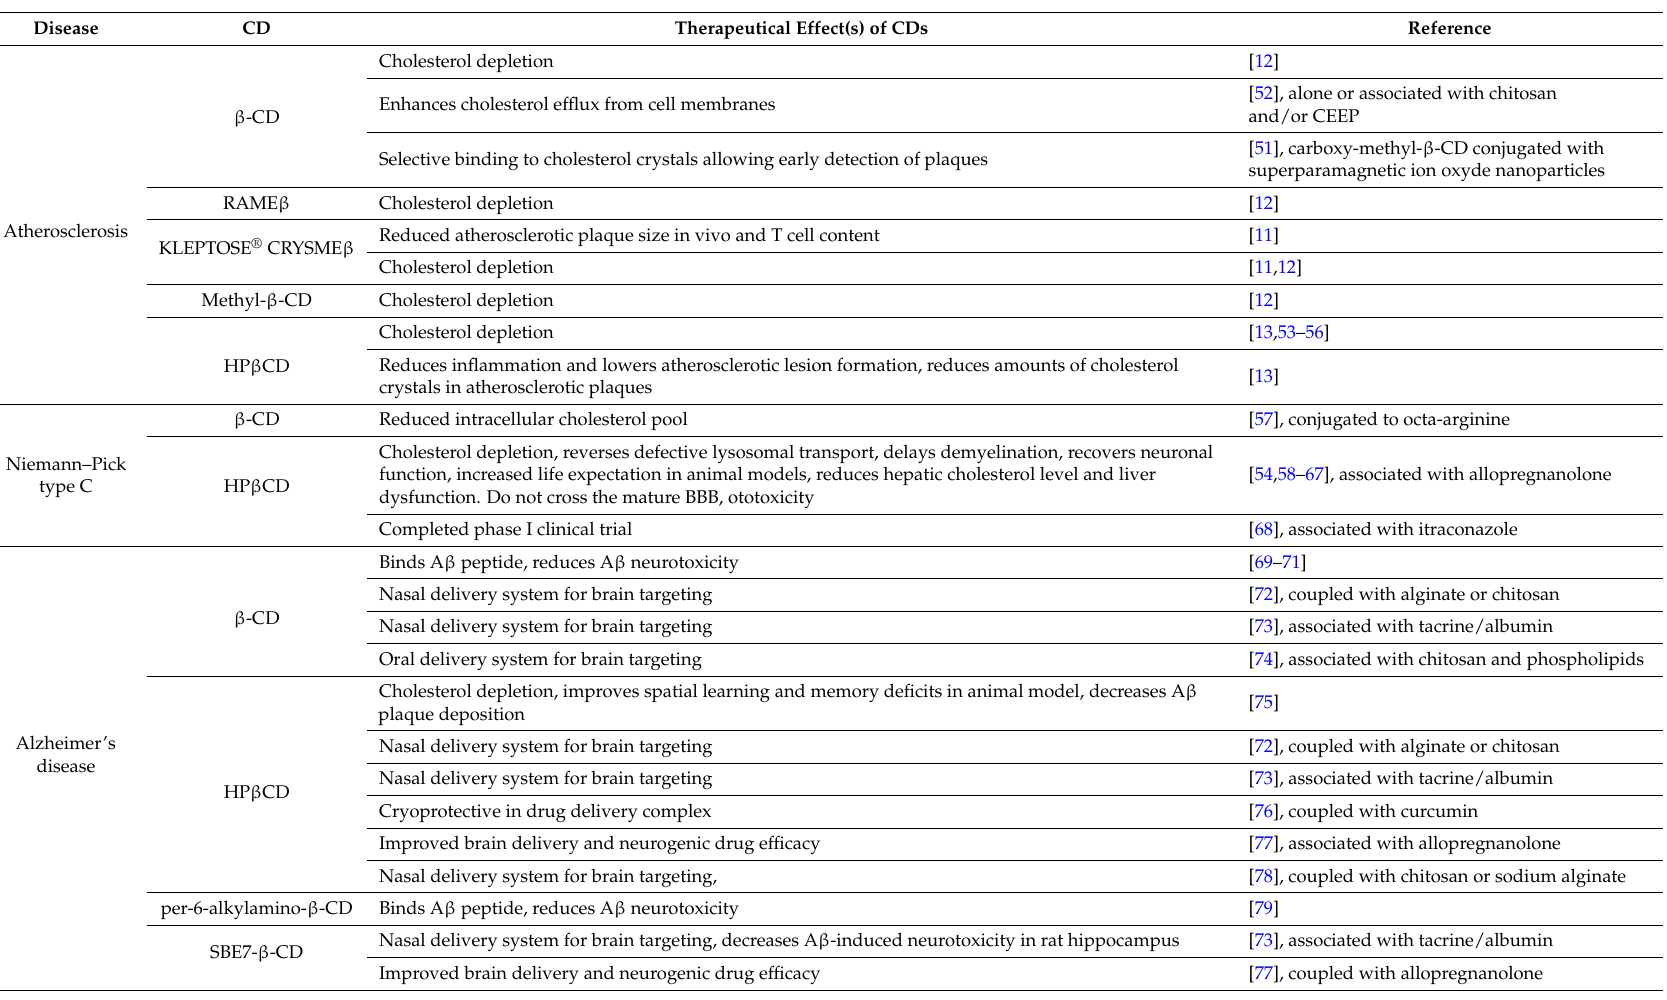
Table 2. Summary of cyclodextrins (CDs) and their therapeutical uses in vascular and neurodegenerative